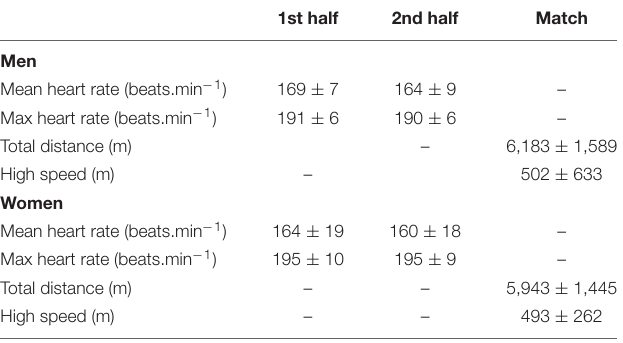
TABLE 2 | Heart Rate and GPS data for male and female athletes. 1st half 2nd half Match